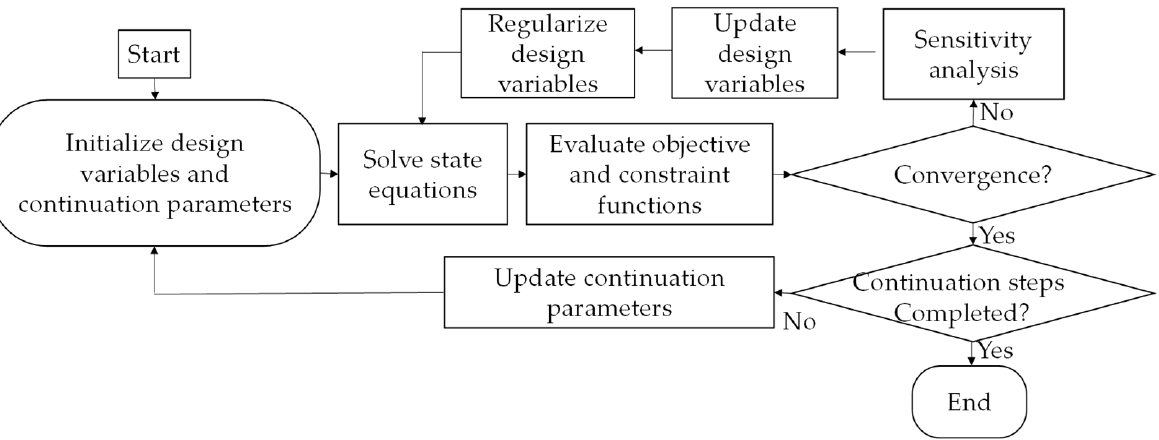
Figure 3. Flow chart of the topology optimization process.